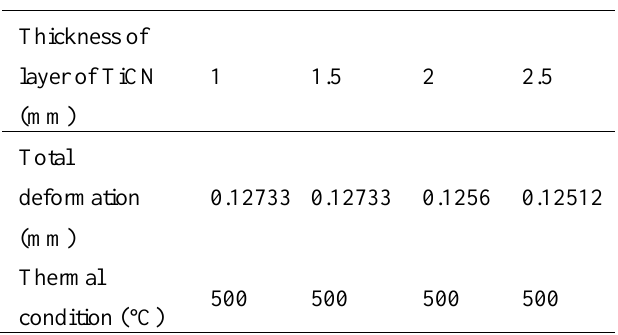
Change total deformation according to changing the thickness of Titanium